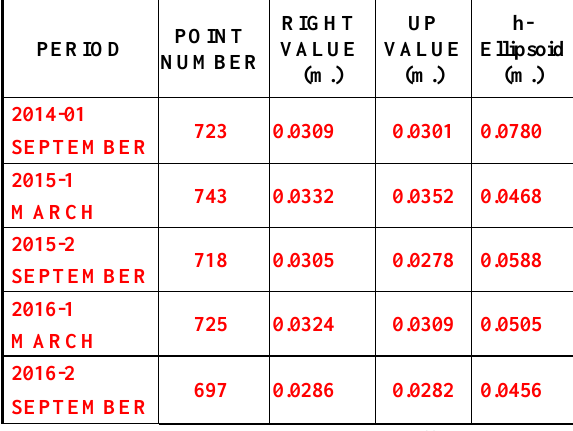
Table 1: Periodic Check Measures results difference table by